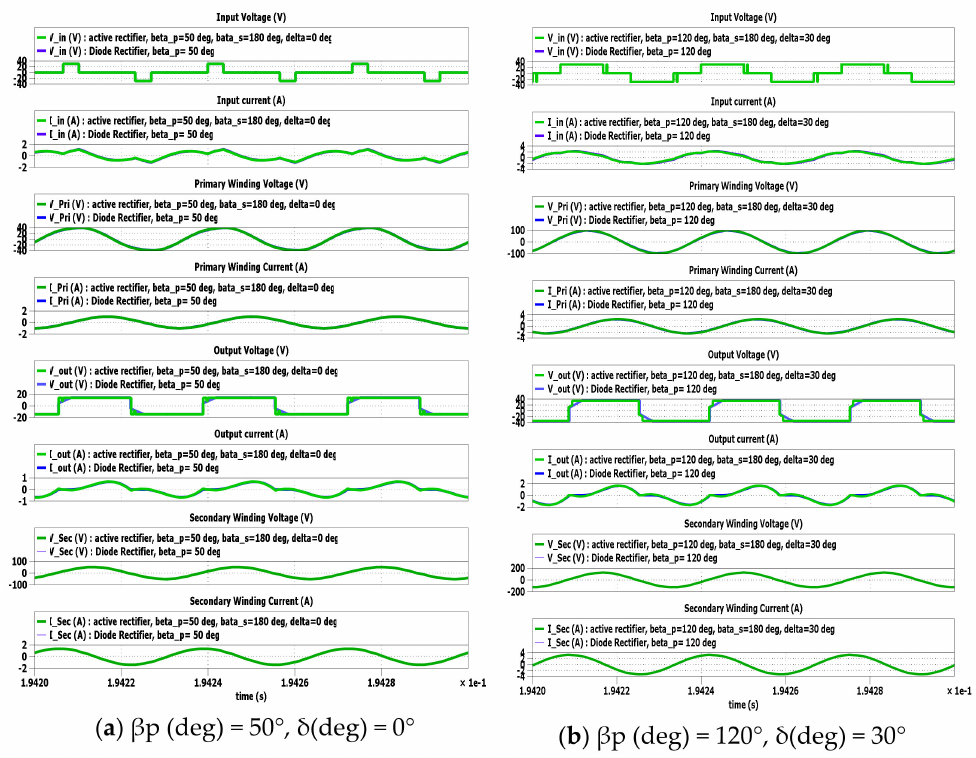
Figure 13. Inverter/rectifier and transformer voltage and current waveforms with TPS open loop control settings to match diode bridge rectifier